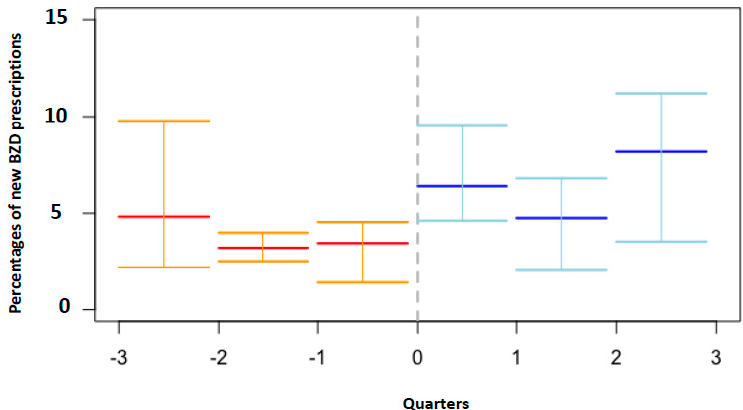
Figure 2. Benzodiazepine prescriptions before and after e-prescribing implementation at the network level. The zero on the x -axis indicates e-prescribing implementation. Quarterly rates of new BZD prescriptions in the period before and after e-prescribing are depicted in red and blue, respectively. The horizontal lines above and below the central value indicate the maximum and minimum BZD rates in the period. Percentages of new BZD prescriptions are depicted on the y -axis.